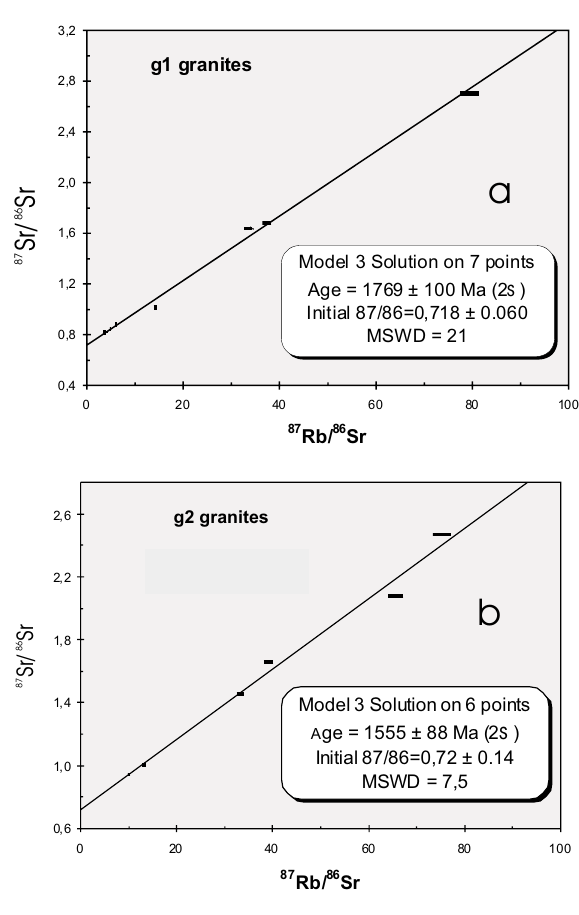
Fig. 4 – Rb-Sr isochrons of g1 (a) and g2 (b) facies of the Serra da Pedra Branca